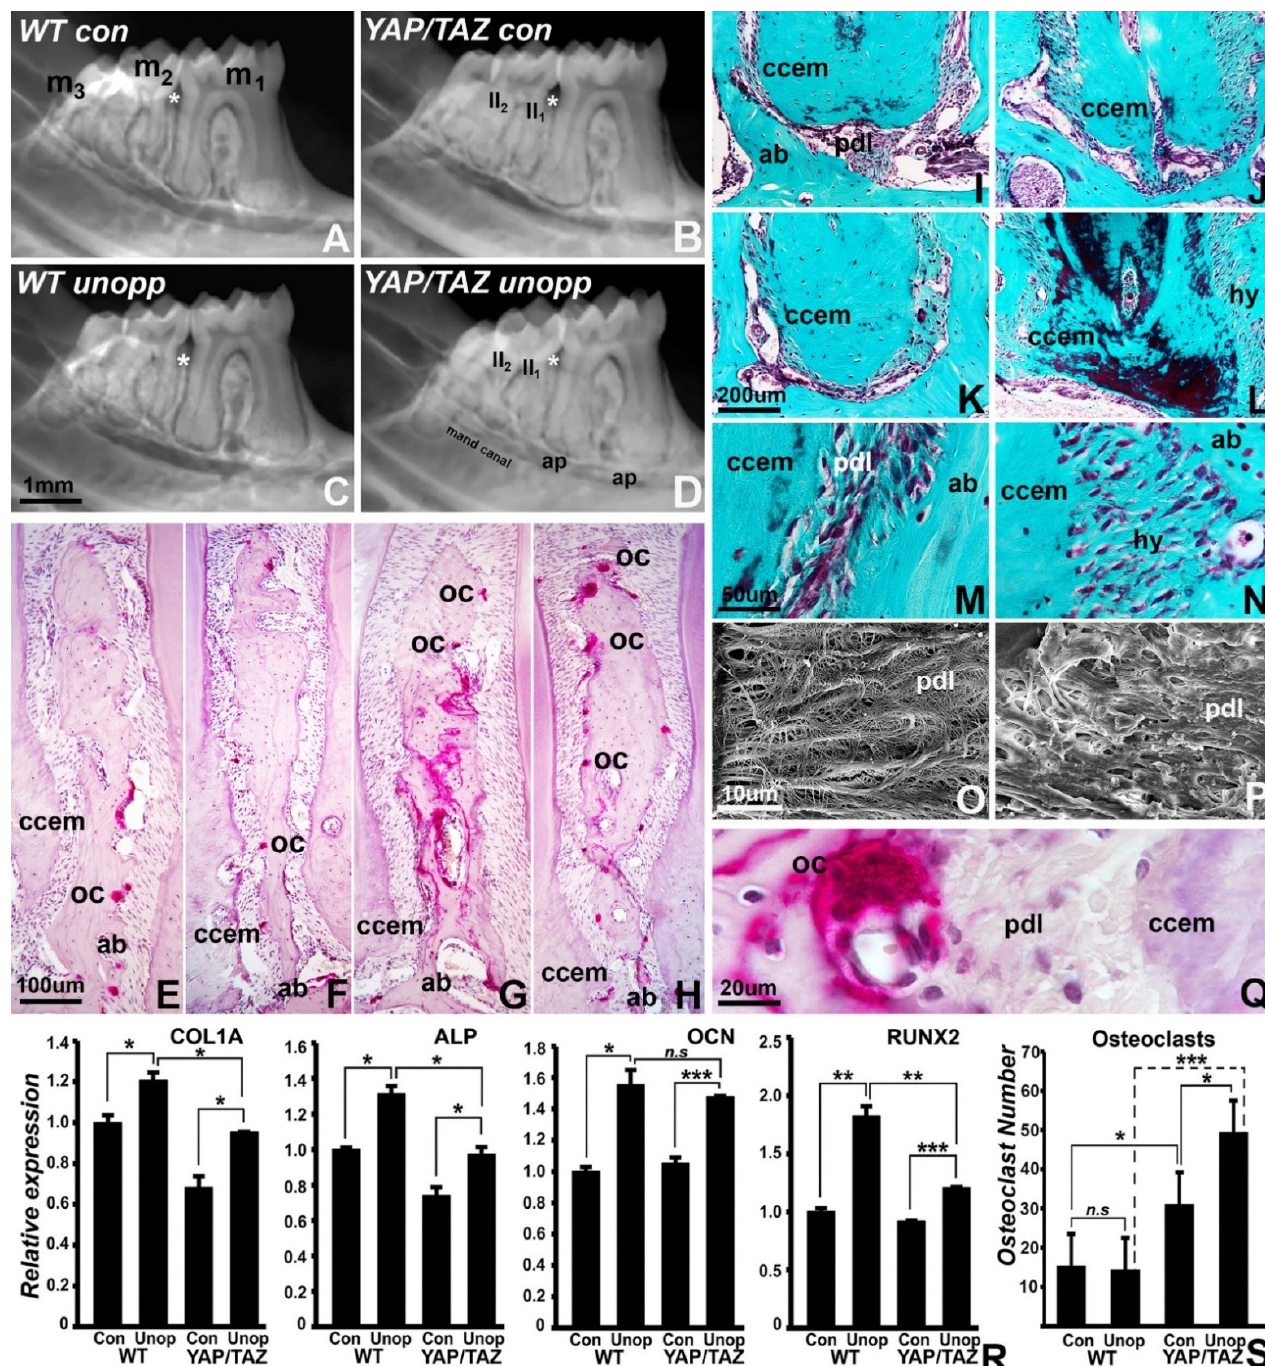
Figure 4. Differential effects of unloading on periodontal microanatomy, homeostasis, and gene expression. ( A – D ) X-ray comparison between molar rows from wild type control ( A ), YAP/TAZ control ( B ), wild type subjected to unopposed molar conditions ( C ), and YAP/TAZ subjected to unopposed molar conditions ( D ). Individual molars are labeled as m1, m2, and m3, and tooth roots of the second molar are labeled as II1 and II2. The asterisk indicates the position of the alveolar bone between the first and second molar. Other areas of interest include the root apices of the first molar (ap) and the mandibular canal (mand canal). Note the differences in bone and cementum boundaries. ( E – H ). Effect of unloading and of loss of YAP/TAZ on osteoclast activity when comparing wild type control ( E ), YAP/TAZ control ( F ), wild type subjected to unopposed molar conditions ( G ), and YAP/TAZ subjected to unopposed molar conditions ( H ). The alveolar bone wall between the first